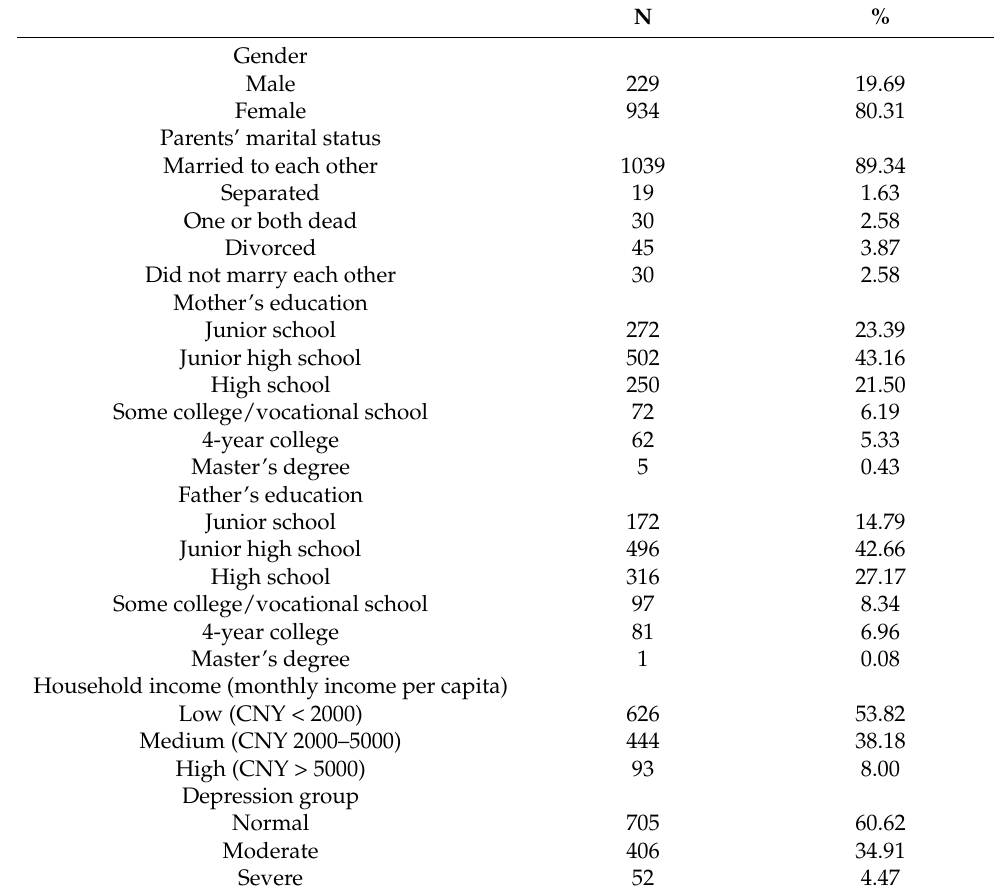
Table 1. Demographic characteristics of participants.